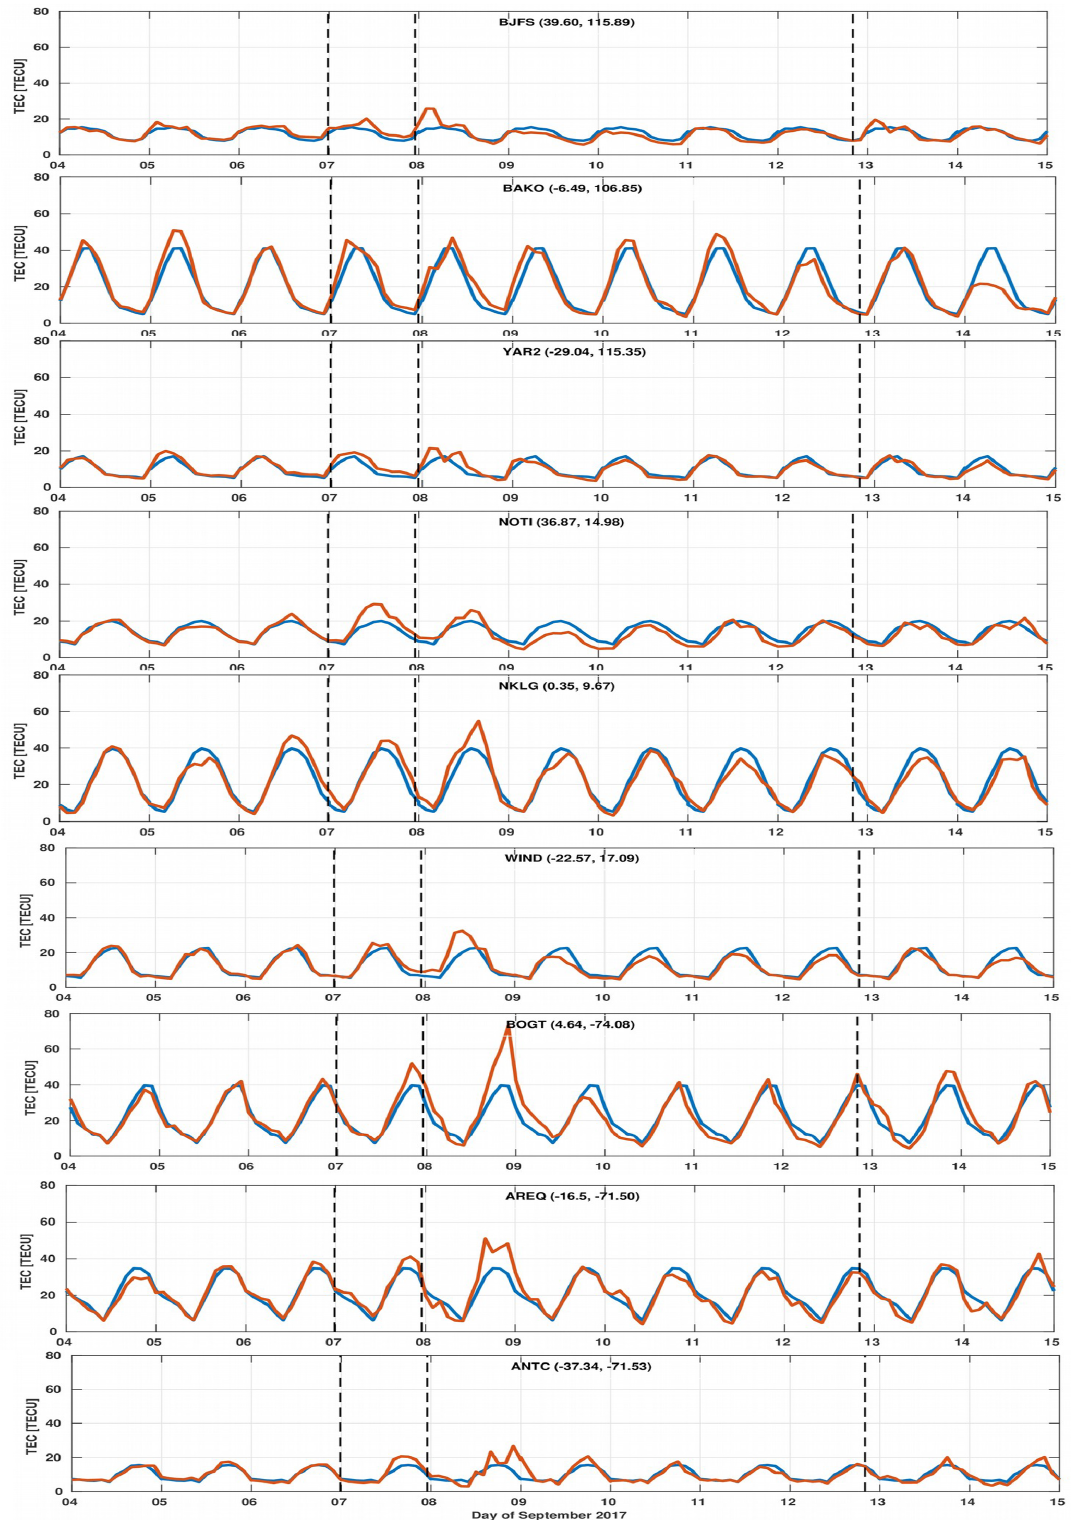
Figure 3. The vTEC variations at GPS stations during the geomagnetic storm of 4–14 September 2017. Each plot illustrates the disturbed vTEC (in orange) and its quiet value (in